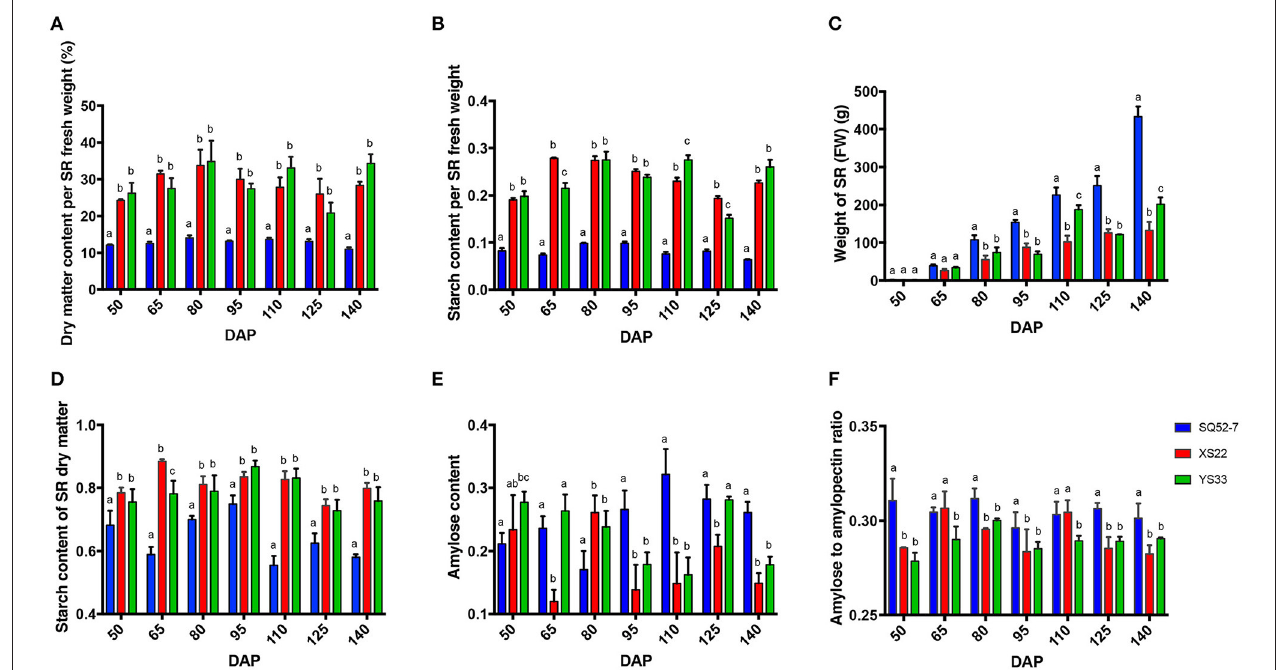
FIGURE 1 | Dynamic changes of dry matter, starch properties, and SR weight during SR development. Dynamic changes of (A) dry matter content per SR fresh weight, (B) starch content per SR fresh weight, (C) SR fresh weight, (D) starch content of SR dry matter, (E) amylose content, and (F) amylose to amylopectin ratio in the SR starch during SR development in the SQ52-7, XS22, and YS33 genotypes. Error bars indicate the standard deviation from three independent replicates.